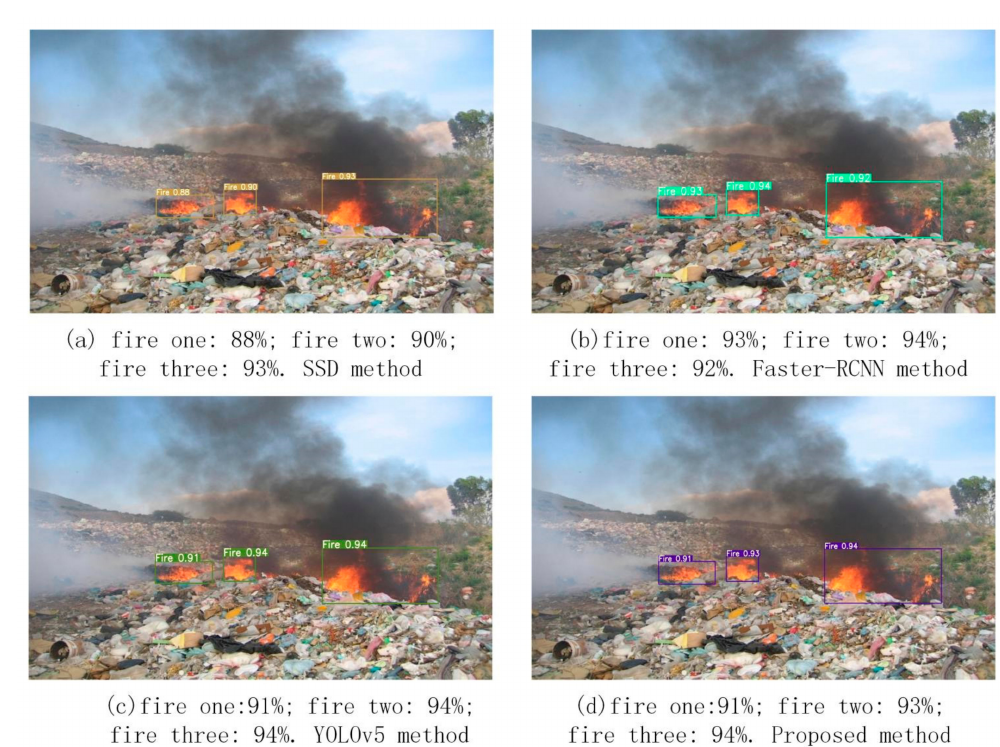
Figure 12. Multi-objective fire